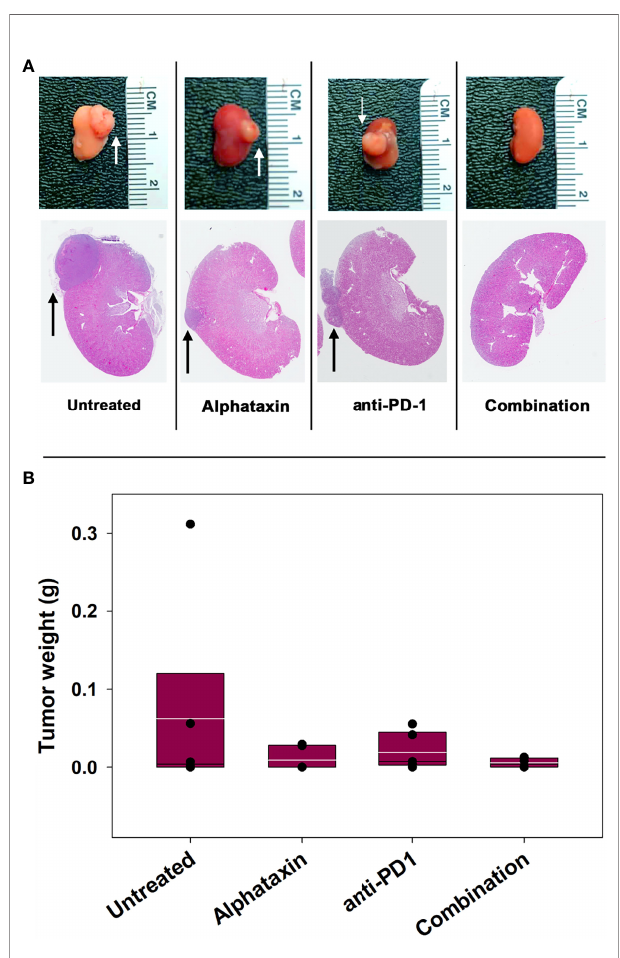
FIGURE 5 | Tumor Growth was Inhibitied by Combination Treatment with Alphataxin and an Anti-PD-1 Antibody. Mice were orthotopically implanted with 5x 10 2 renal carcinoma cells, and treatment was initiated 7 days later. (A) Excised kidneys were compared for gross morphology (row 1) and by H&E staining (row 2). Images were captured at identical magni fi cation, and representative images at 1X are depicted with tumors indicated by arrows. (B) The tumor weight of each animal was calculated as the difference between the weight of the left tumor-bearing kidney and that of the right non- tumor-bearing kidney from each mouse assuming that the left and right kidneys are symmetrical and have approximate equal weights other than the added tumor weight. Tumor weights were not normally distributed. Medians, depicted by black lines within box plots, were compared using Kruskal-Wallis ANOVA of ranks (n = 6/arm). White lines within box plots depict